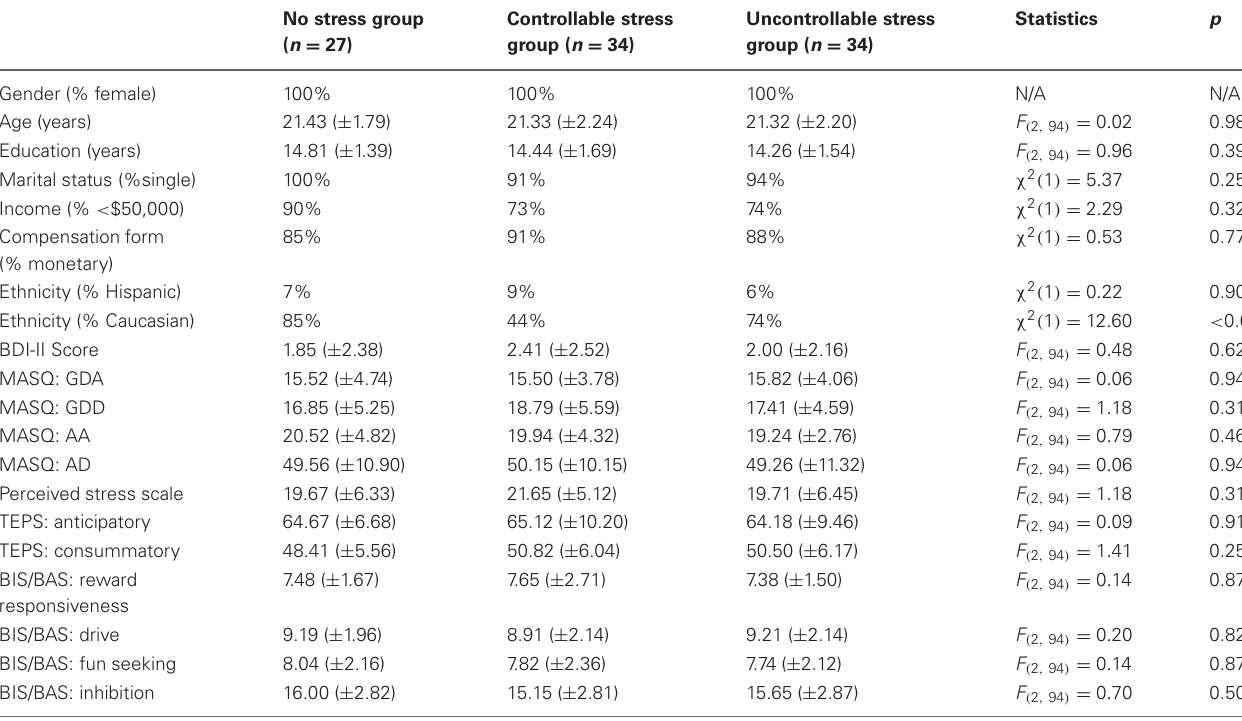
Table A1 | Demographics, trait and dispositional self-report measures of the original three groups.